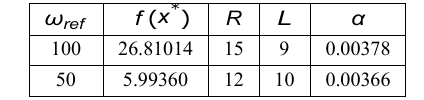
Figure 6. Speed of DC motor controlled by DMC tuned by heuristic method (ωref = 100 rad/s).